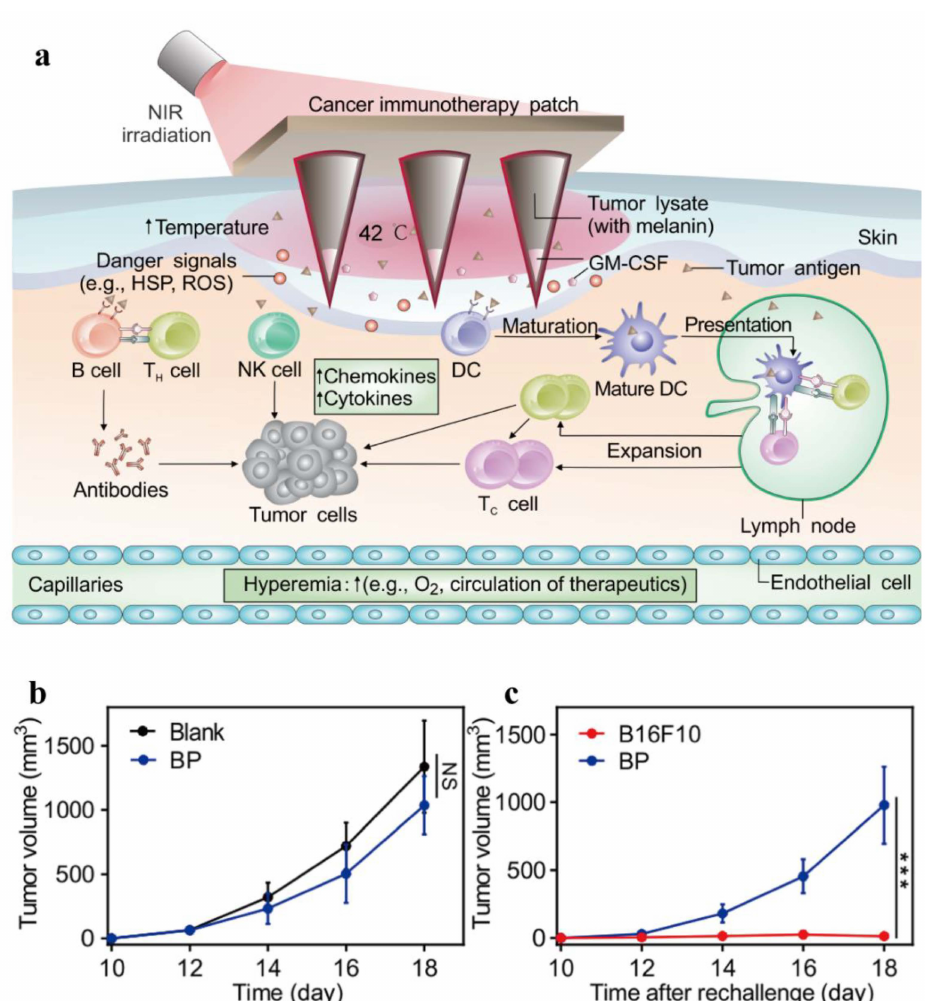
Figure 11. A transdermal MN-based vaccine patch for photothermal assisted immunotherapy. ( a ) Schematic illustration of melanin-based transdermal vaccination. ( b , c ) anti-tumor effect of local cancer immunotherapy treatment toward distant B16F10 tumors. Average tumor volumes in vaccinated mice rechallenged with either B16F10 cells or BP cells on day 80 ( b ) and Kaplan-Meier survival curves for rechallenged mice ( c ) [109]. Data points represent mean ± SD ( n = 8). Error bars indicate SD. Statistical significance was calculated by Student’s t test and log-rank test (NS, p > 0.05; *** p <